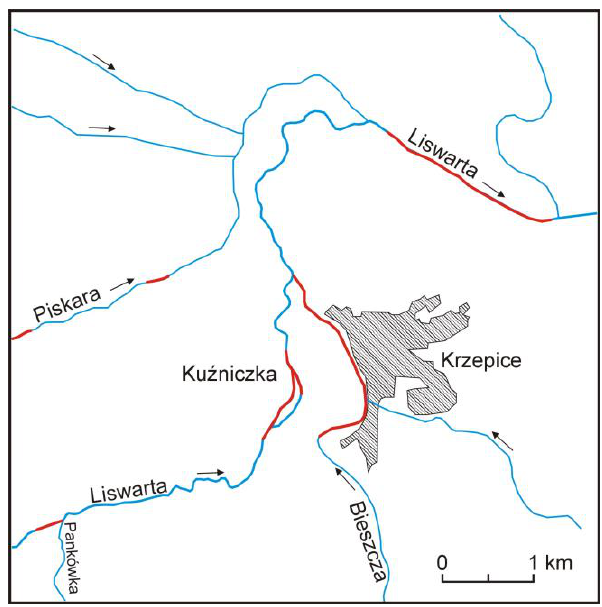
Fig. 7. Reaches of the Rivers Liswarta and Bieszcza channels (marked in red), which are old mill races and channel sections whose location was changed in order to serve watermills (own